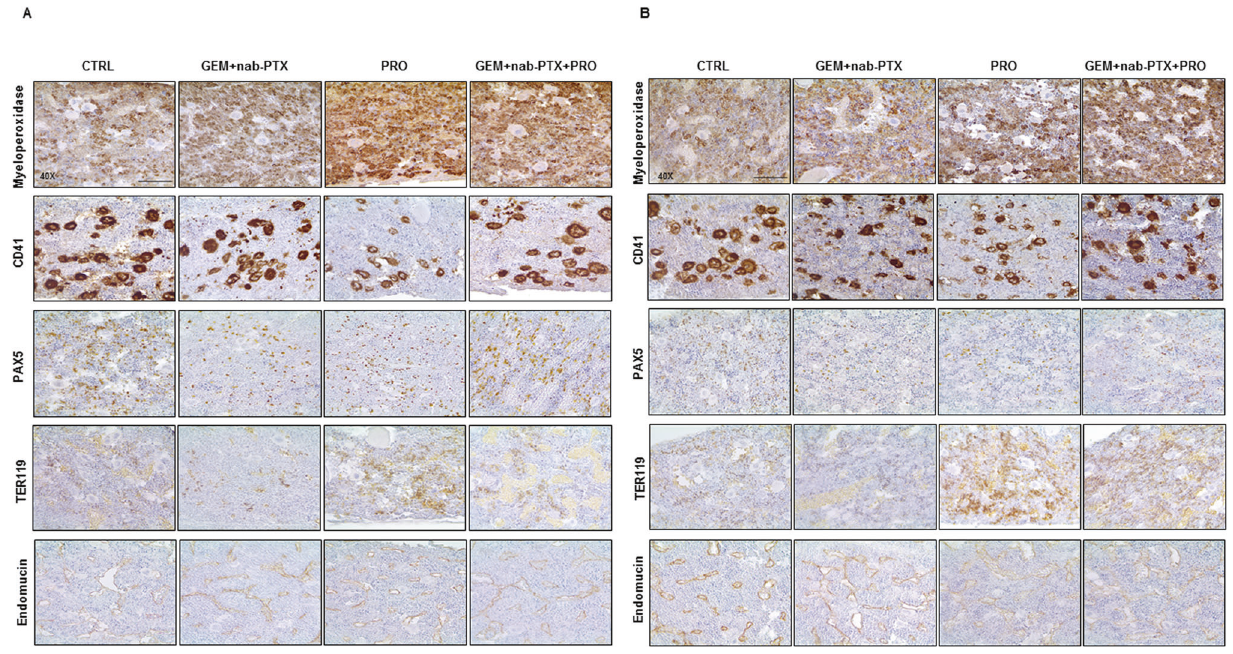
Fig. 3 Chemotherapy and/or probiotic treatment induce changes on mice hematopoiesis. Representative microphotographs of immunohistochemistry for Myeloperoxidase, CD41, PAX5, Ter119, and Endomucin in BxPC-3 ( A ) and PANC-1 ( B ) bone marrow sections. All pictures were taken at ×40 magni fi cation. Scale bar 50